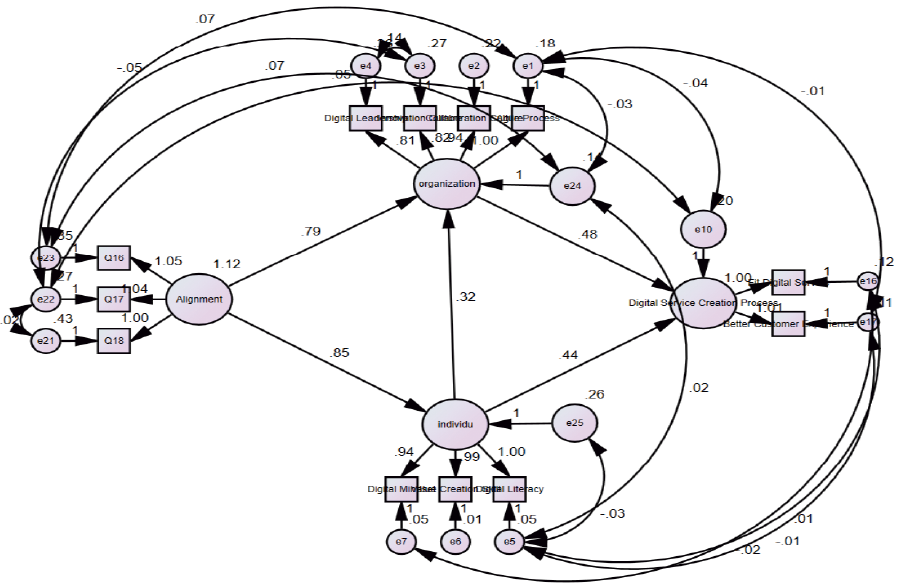
Figure 4. Structural Equation